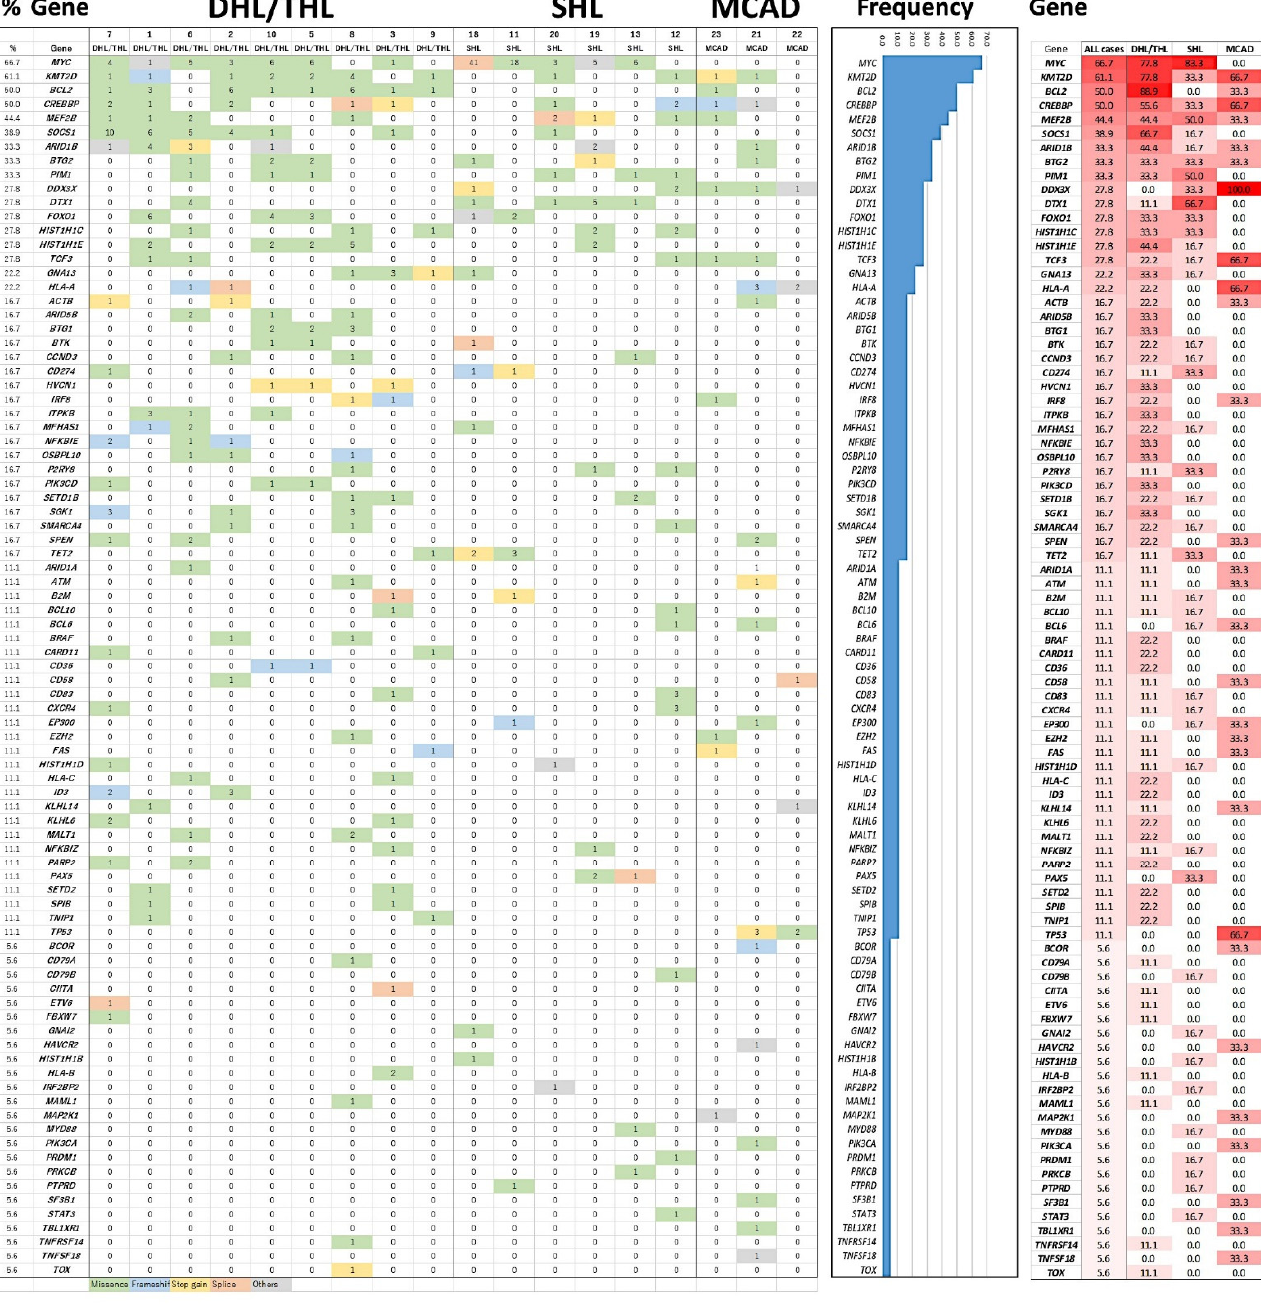
Figure 2. Targeted next-generation mutational profile. The most frequently mutated genes in all cases were MYC , KMT2D , BCL2 , and CREBBP . The total number of mutations per gene is shown. Missence, green; frameshift, blue; stop gain, yellow; splice, red; and others, grey. On the right, the percentage of cases with mutation is shown in all cases and each group.